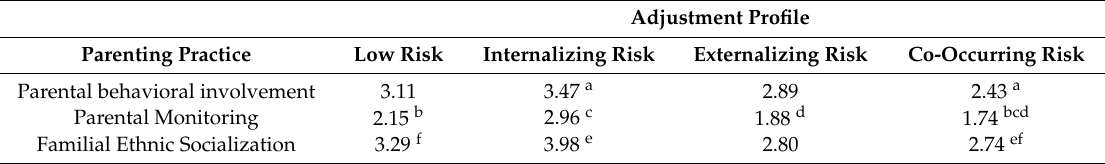
Table 2. Mean di ff erences of parenting practices by youth adjustment